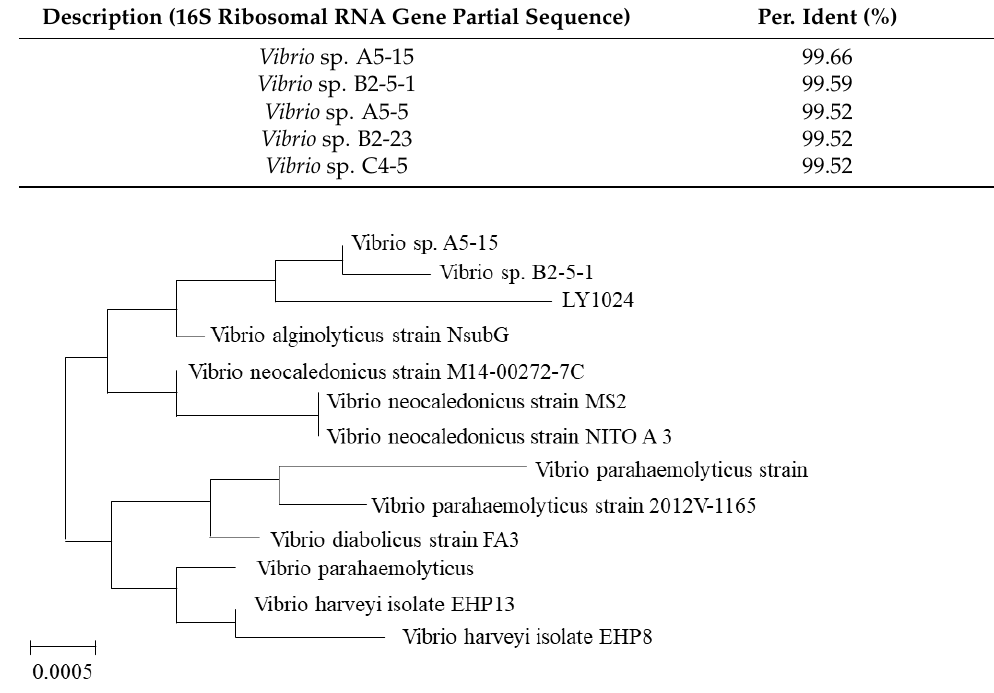
Figure 2. Phylogenetic tree of strain LY1024 .